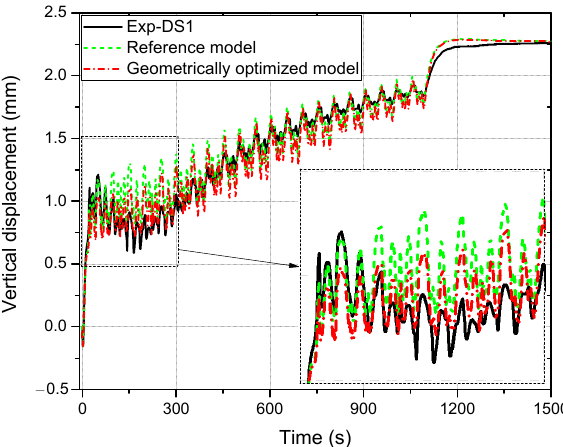
Figure 5. ( a ) Varying layer sizes in the initial building stage (see Figure 1); ( b ) modified geometric mesh model referring to the actual workpiece.